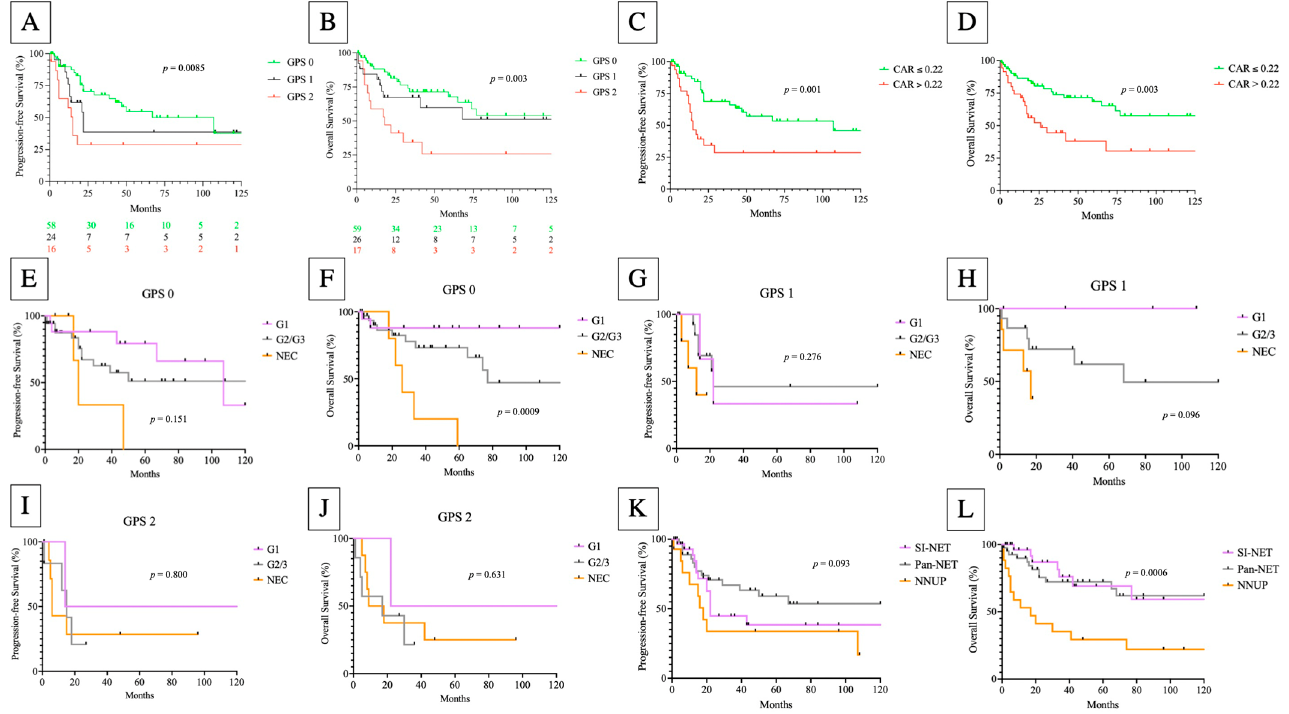
Figure 3. Progression-free ( A , C , E , G , I , K ) and overall ( B , D , F , H , J , L ) survival according to the Glasgow Prognostic Score (GPS) (log-rank GPS 0 vs. GPS 1 vs. GPS 2; ( A , B )), CRP/albumin ratio (CAR) (log-rank test; ( C , D )) and primary tumor sites (log-rank test; ( K , L )) in GEP-NEN patients. ( E – J ) The Kaplan–Meier analysis (PFS and OS) according to the histological grading among the GPS subtypes.